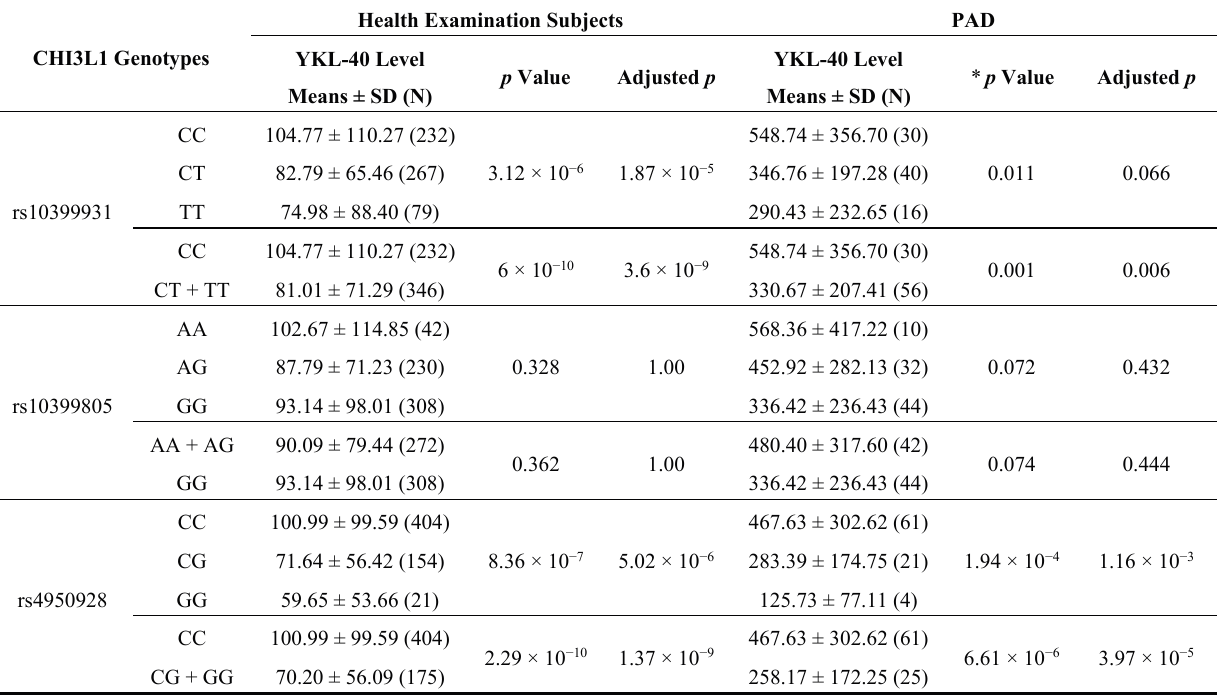
Table 5. Association between CHI3L1 genotypes and YKL-40